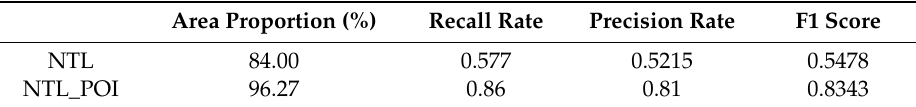
Table 2. Comparison of NTL and NTL_POI recognition